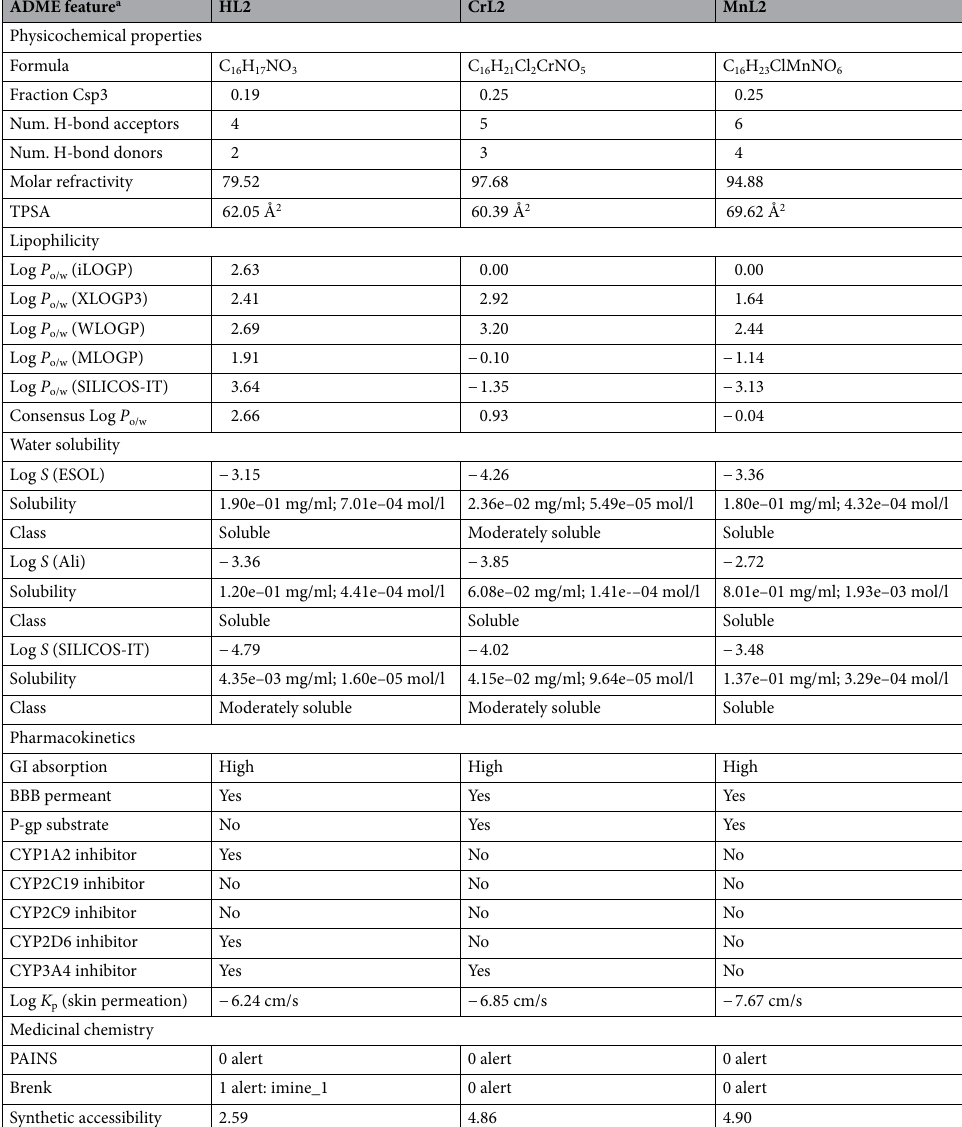
Table 13. ADME analysis of the HL2 and its complexes. a TPSA topological polar surface area, Consensus LogP o/w : Average of all five predictions, GI absorption: Gastrointestinal absorption, P-gp substrate: P-glycoprotein substrate, CYP1A2 inhibitor: Cytochrome P450 1A2 inhibitor, CYP2C19 inhibitor: Interference Structures, Brenk: Structural Alert, Synthetic accessibility score: from 1 (very easy) to 10 (very